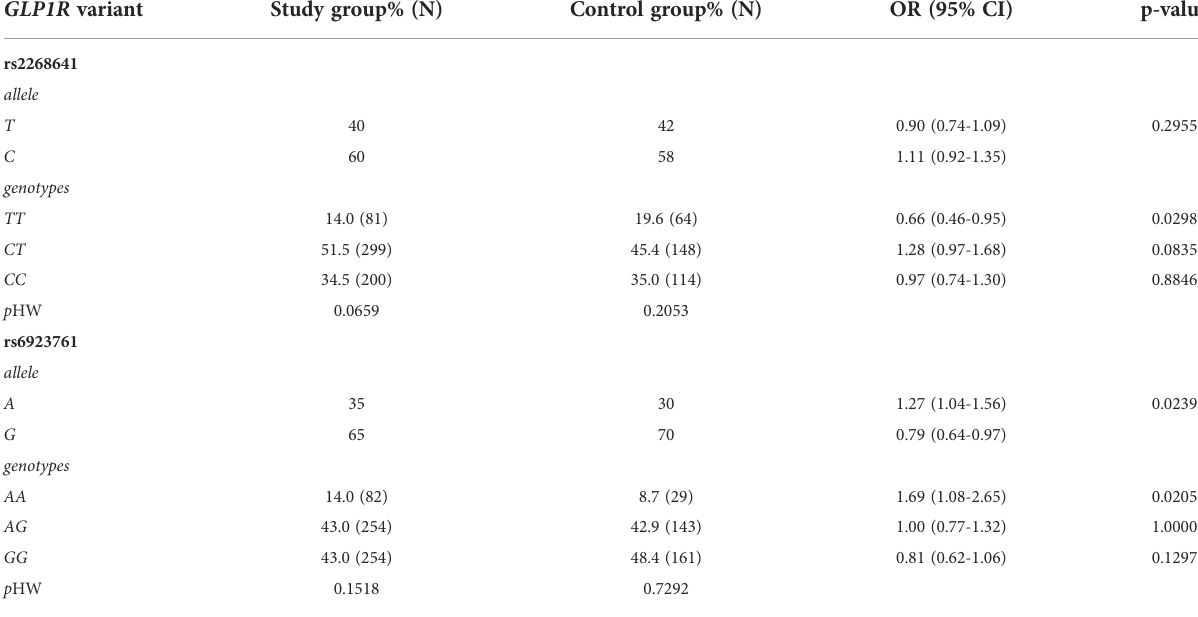
TABLE 2 The frequencies of GLP1R variants in the study and the control group. GLP1R